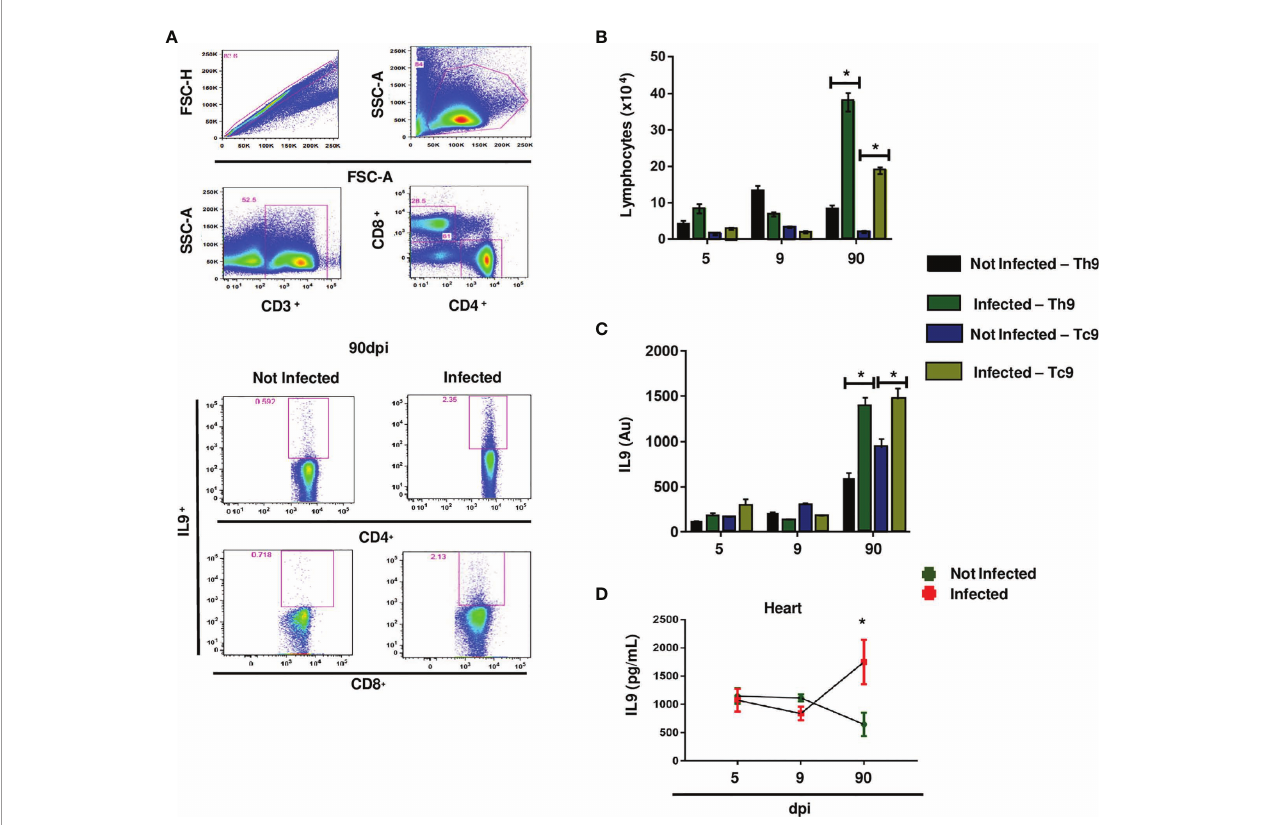
FIGURE 5 | Y strain infection increasedTh9 andTc9 cells, synthesisofIL-9 insplenocytes, andcardiac IL-9 levels during chronicinfection.Representative dot plots of frequency analysisofTh9 andTc9 cells inthe spleen after 90 dpi (A) . For selection of the population of interest, aggregates were excluded andlymphocytes were selected bysize X granularity ( fi rst line of panels).Then, mature lymphocytes were selected (CD3 + ) and CD4 + and CD8 + lymphocytes were separated from them (second line of panels). CD4 + and CD8 + populationswere de fi ned as Th9 andTc9 subpopulations(third andfourth line ofpanels, respectively).Absolute number ofCD3 + CD4 + IL-9 + T cells andCD3 + CD8 + IL-9 + T cells (B) . Arbitraryunits (Au)of IL-9 expression (C) . Quanti fi cation of IL-9 inthe hearts of BALB/c mice (D) . Anova test*p <